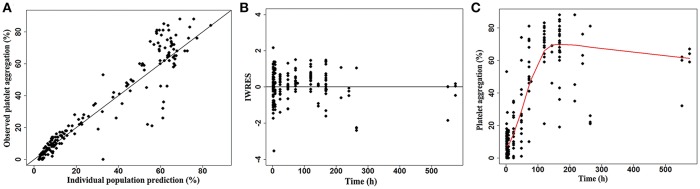
Sigmoid maximal effect model of platelet aggregation. Goodness of fit plots: (A) Observed vs. individual population predicted values; (B) individual weighted residuals vs. time; (C) scatter plot of time vs. platelet aggregation, and the prediction curve.